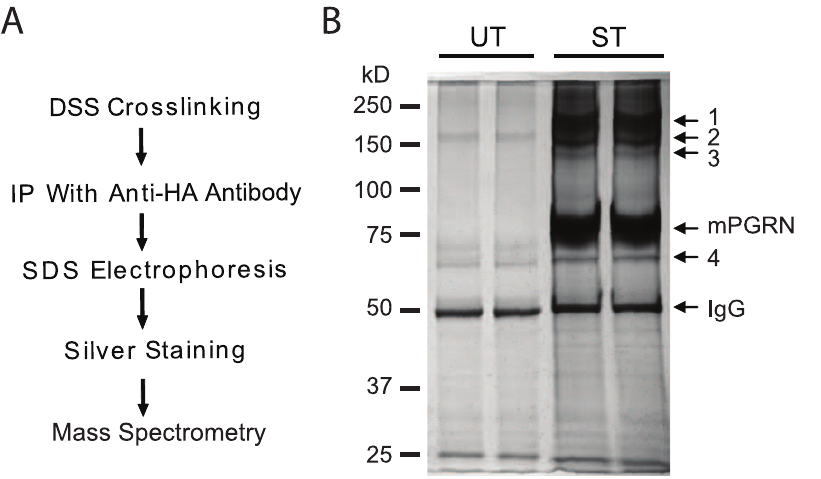
Figure 2. Biochemical identification of PGRN-interacting proteins. ( A ) Description of the experiment in C . mPGRN-HA stably transfected HEK293 cells were treated with the chemical crosslinker DSS. Immunoprecipitation was performed with an anti-HA antibody. The immunoisolates were analyzed by SDS-PAGE, which was then silver stained. Specific bands were cut out and analyzed by mass spectrometry. ( B ) Image of a gel after silver staining. The identities of bands 1–4 are listed in Table